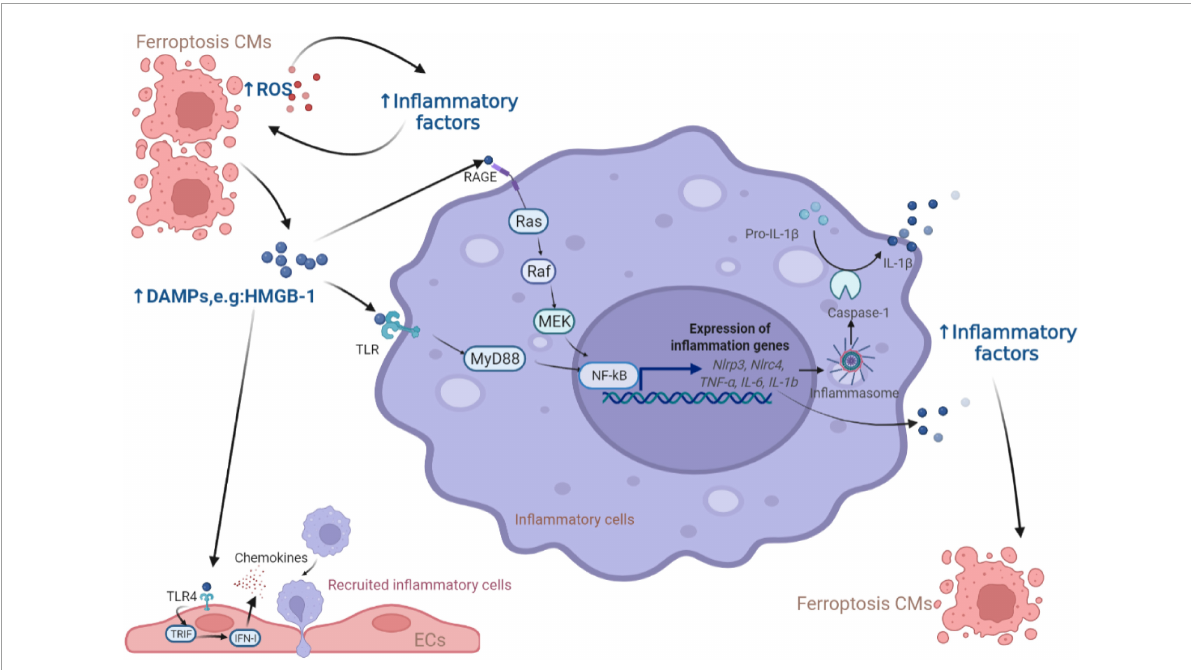
FIGURE2 The role of DAMPs released from ferroptotic CMs in inflammation. The release of DAMPs from ferroptotic cells activates the downstream NF- κ B inflammatory pathway through the TLR and RAGE receptors of inflammatory cells, leading to the production of inflammatory factors (e.g., NF- κ B, IL-6, IFN- γ , TNF- α , and IL-1 β ) which were also produced due to the increase of ROS to induce more CMs ferroptosis. In addition, ECs respond to DAMPs via TLR4 receptors and release chemokines to promote more inflammatory cells entering the myocardial microenvironment. CM, cardiomyocyte; ROS, reactive oxygen species; DAMP, damage-associated molecular pattern; HMGB, high mobility group box; RAGE, receptor for advanced glycation end products; TLR, Toll-like receptors; MEK, mitogen-activated protein kinase kinase; NF- κ B, nuclear factor-kappa B; NLRP, NOD-like receptor thermal protein domain associated protein; NLRC, NLR family CARD domain containing; MyD88, myeloid differentiation factor 88; IL, interleukin; TRIF, TIR-domain-containing adapter-inducing interferon- β ; IFN, interferon; EC, endothelial